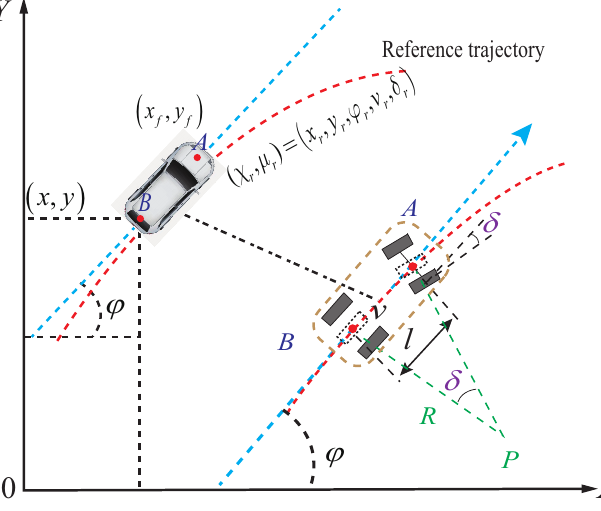
Figure 1. The basic structure of an autonomous vehicle